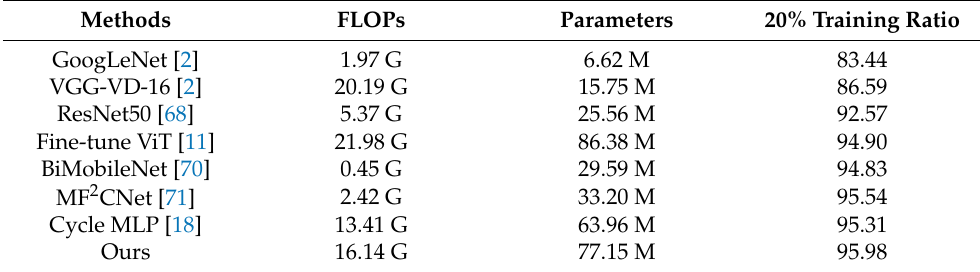
Table 5. Comparison of computational costs and parameters on the AID dataset.